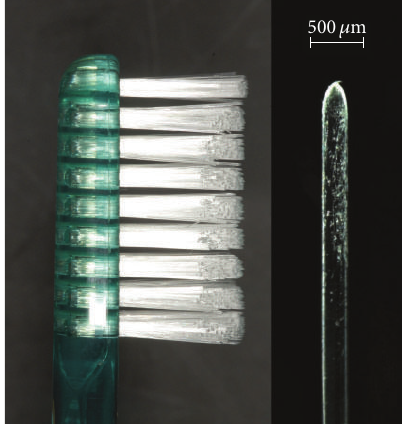
Figure 2: The head of the control toothbrush (TB2) and a soft-end cylindrical